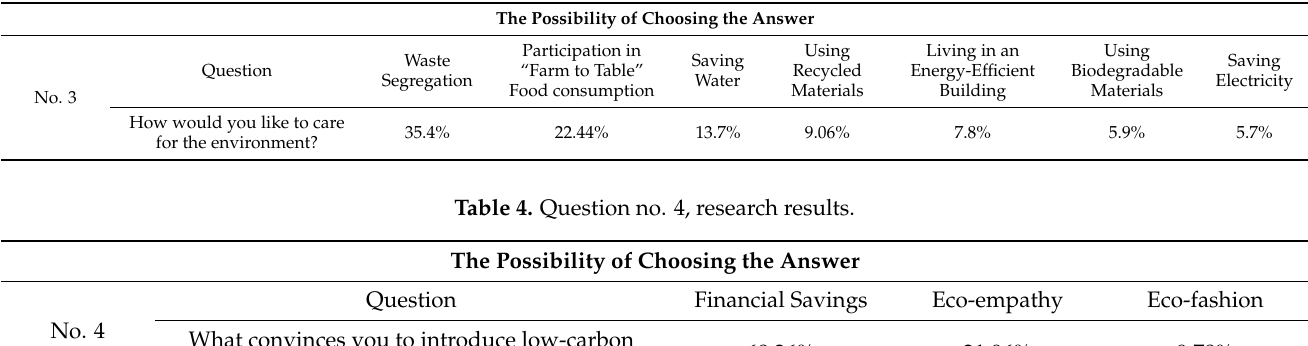
Table 3. Question no. 3, research results.